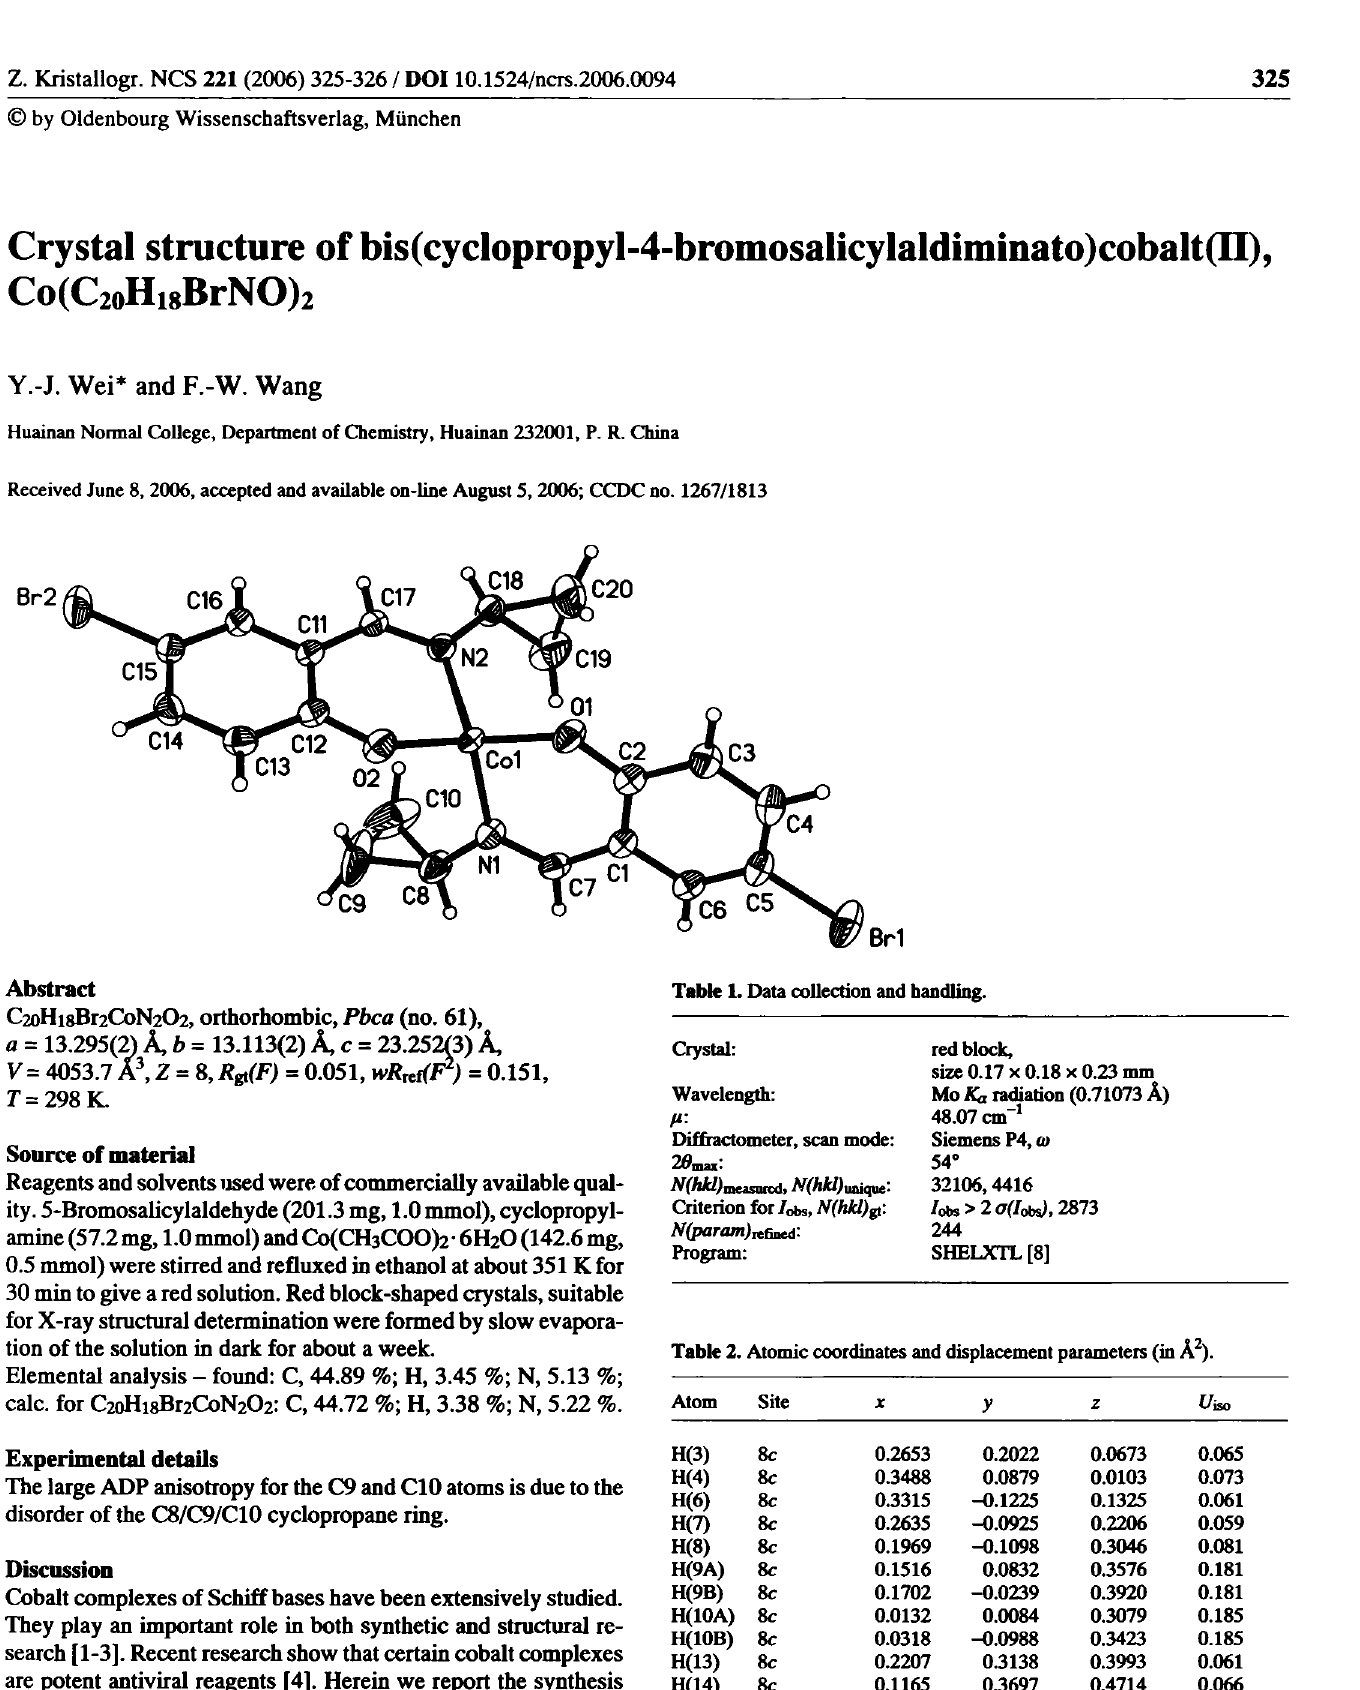
Table 2. Atomic coordinates and displacement parameters (in A 2